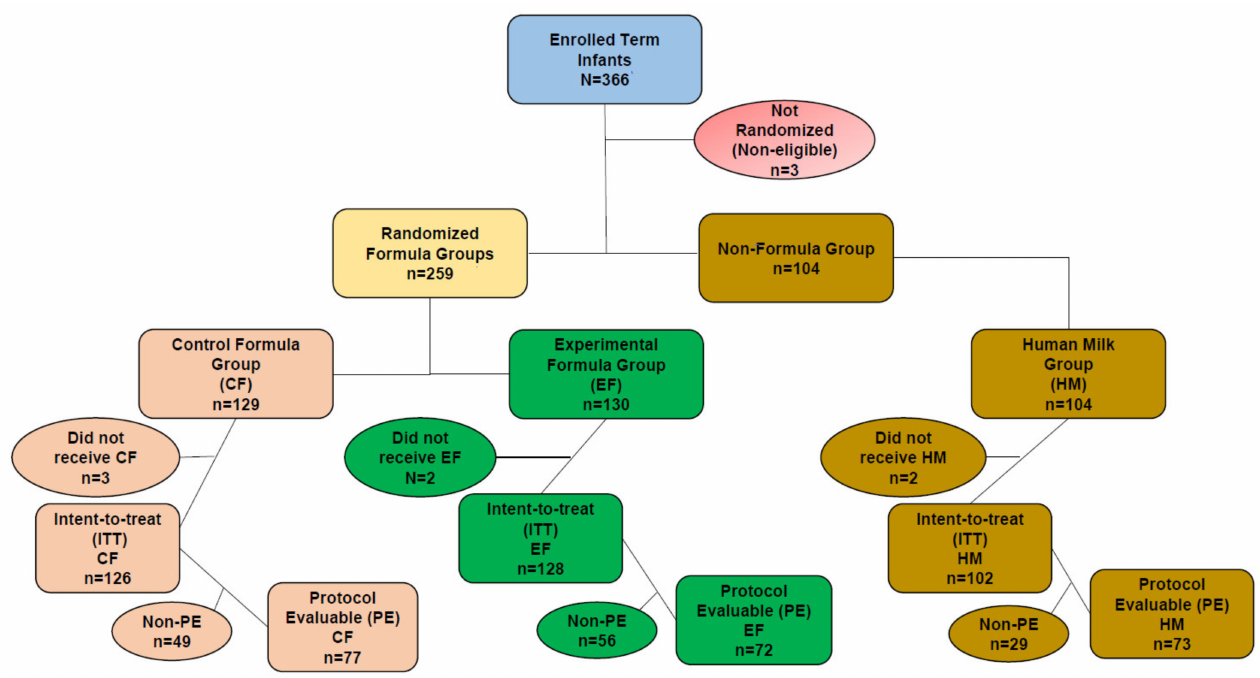
Figure 2. Disposition of participants.